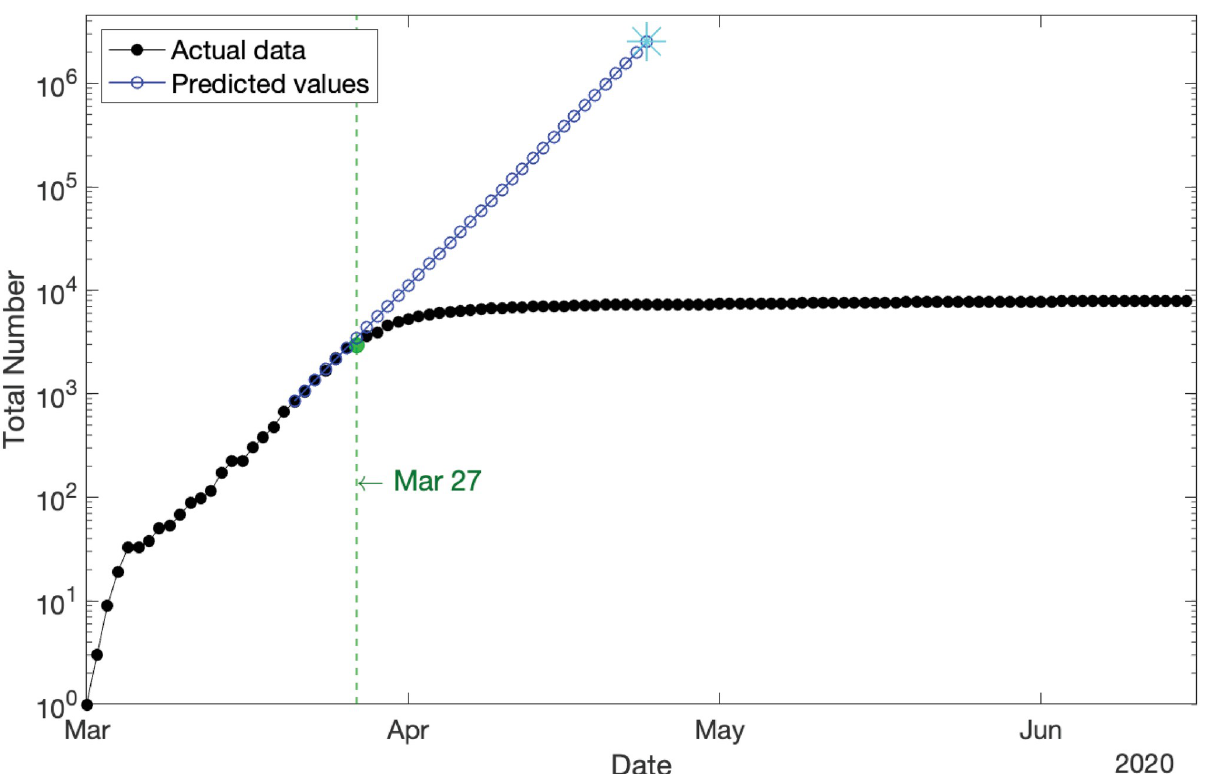
Fig 3. Cumulative new COVID-19 cases in Australia for the whole span of the data (in logarithmic scale) compared with the predicted values for the scenario in which the lockdown restrictions had not been implemented. It shows the exponential growth of the COVID-19 population before the impact of lockdown restrictions on 27 March 2020 (marked in